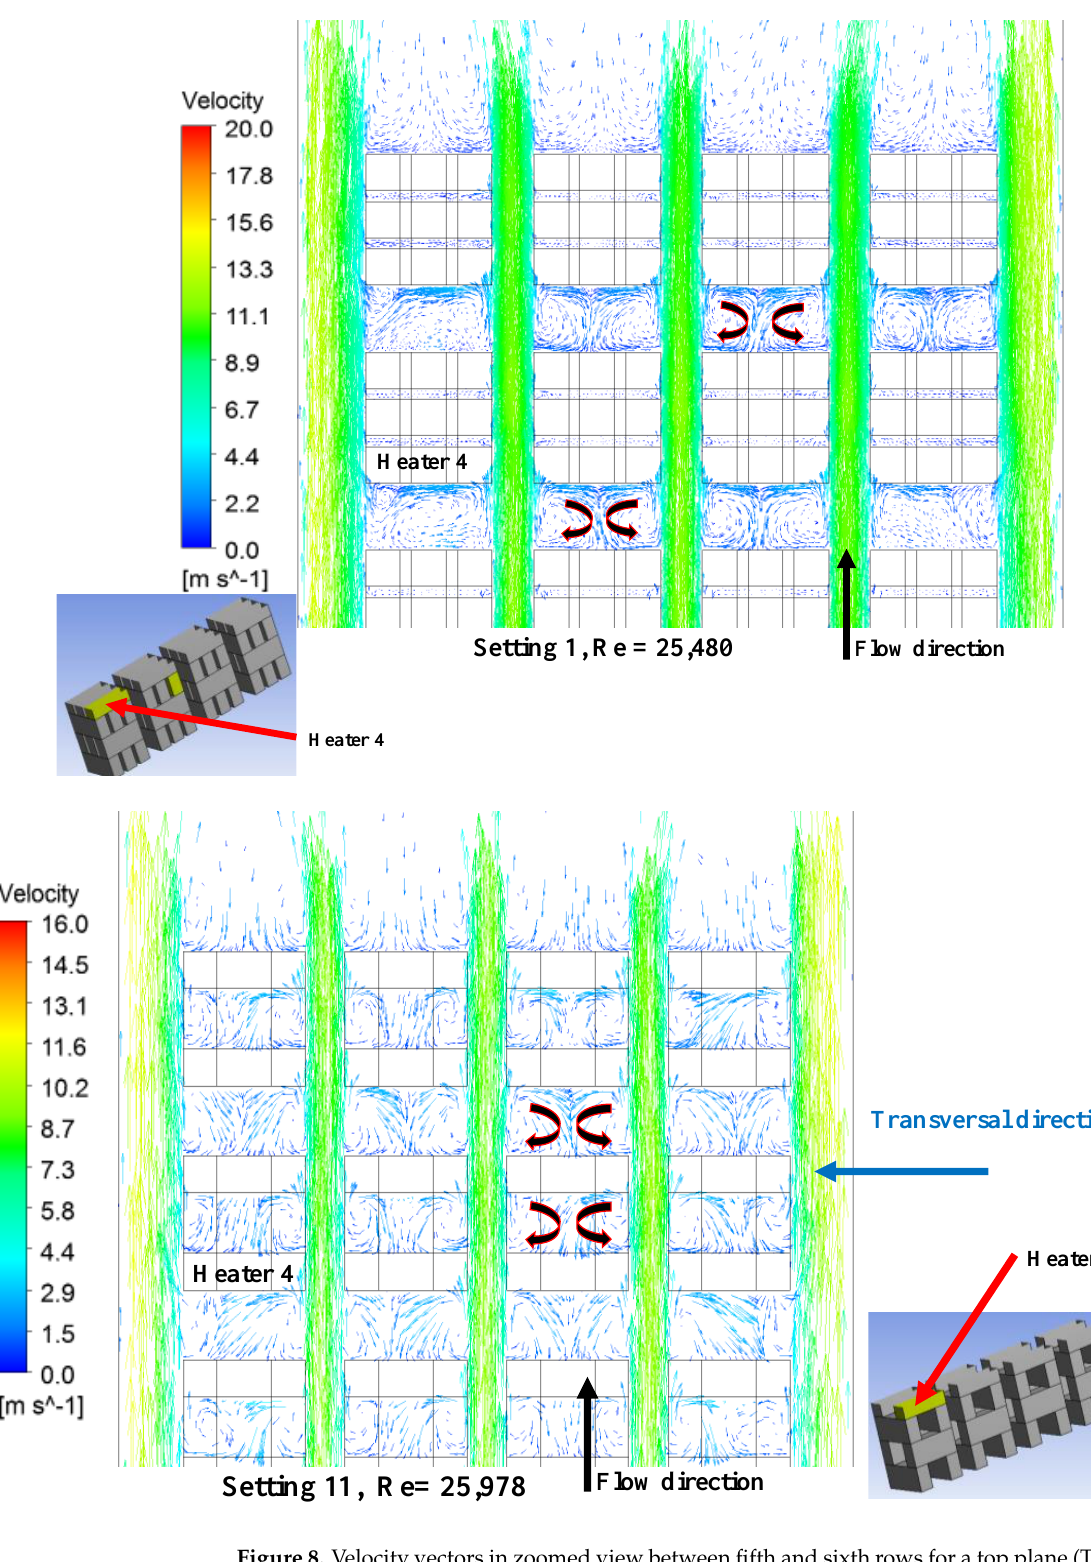
Figure 8. Velocity vectors in zoomed view between fifth and sixth rows for a top plane (Top 4) passing through heater 4.